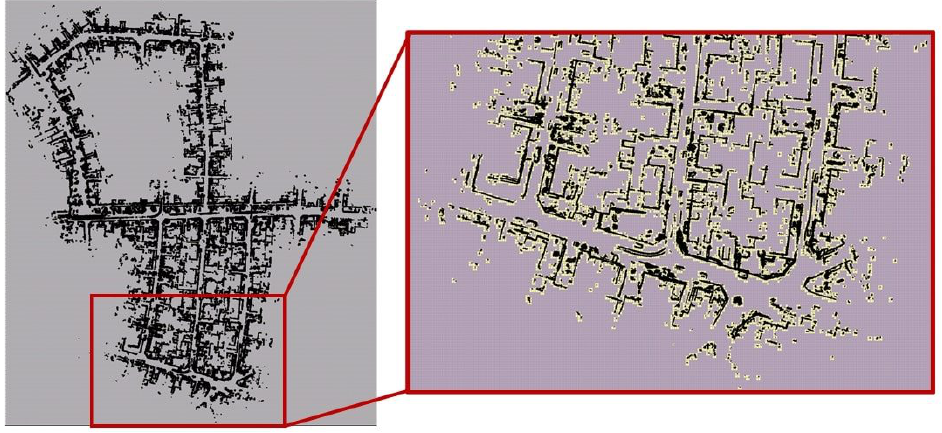
Figure 5. Level L 4 resolution with zoomed-in view at a particular